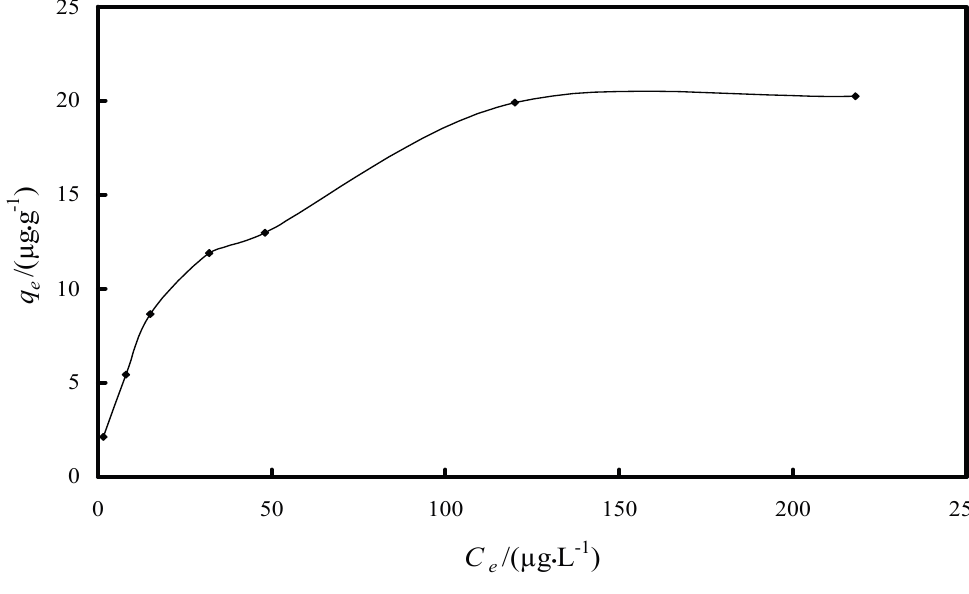
Figure 9. Langmuir isotherm model for As(V) adsorption onto Fe-XAD8-DEHPA